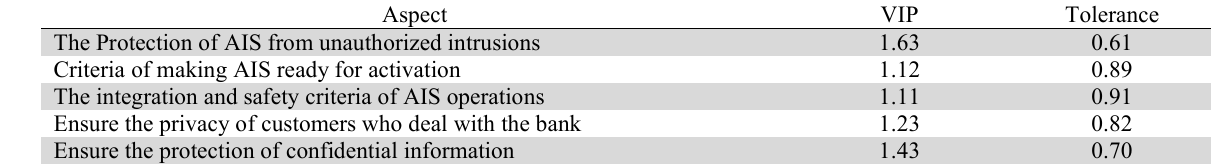
Test interference (correlation) between the independent variables (VIF value) and Tolerance Aspect The Protection of AIS from unauthorized